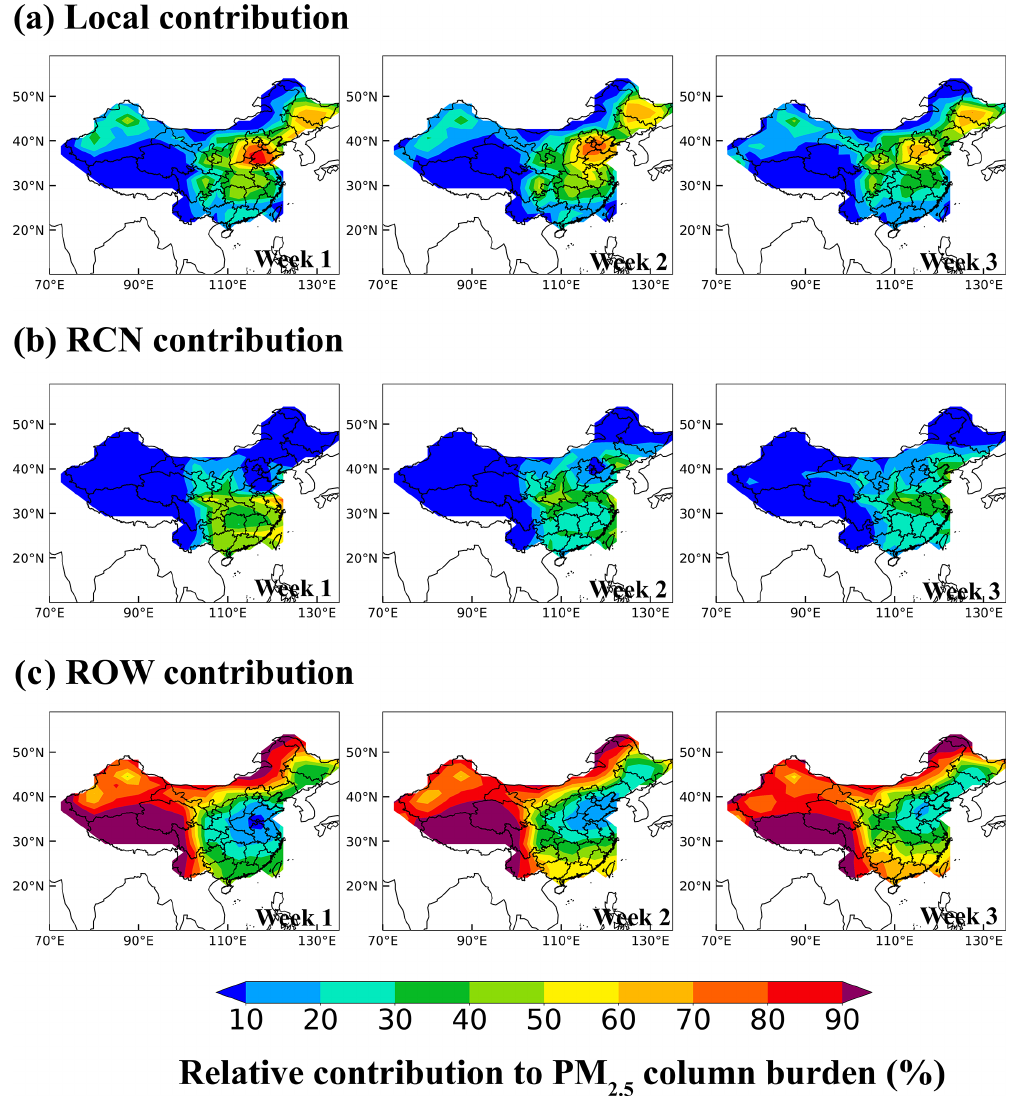
Figure 6. Relative contributions (%) of (a) local emissions, (b) the emissions from the rest of China (RCN) and (c) all sources outside China (rest of the world, ROW) to PM 2 . 5 column burden during the three time